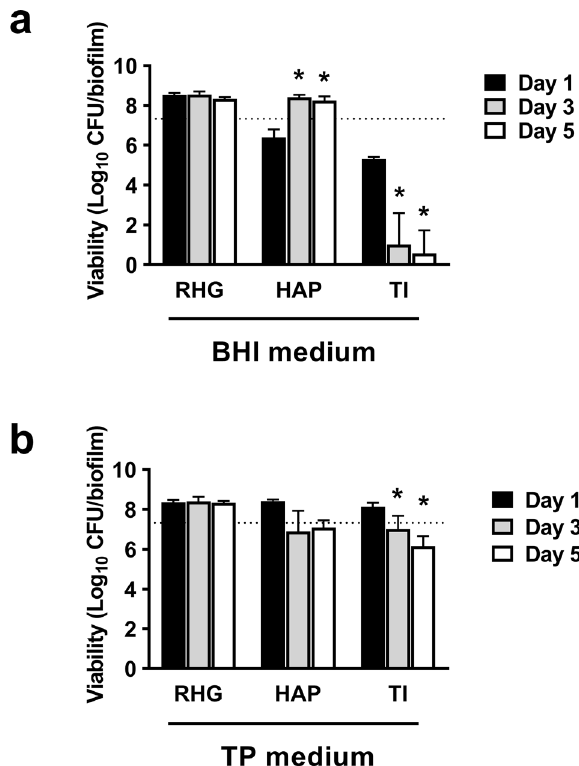
Fig. 1 Viability of microcosm bio fi lms grown on different oral substrata. The saliva inoculum was mixed with 0.7% agar containing bio fi lm growth media — either BHI ( a ) or TP ( b ), and inoculated onto one of the substrata (RHG, HAP or TI). The bio fi lms were collected for viable cell counts on day 1, 3 and 5. RHG: reconstructed human gingiva; HAP: hydroxyapatite discs; TI: titanium discs. Data represent the mean ± standard deviation of three independent experiments. * represents statistically signi fi cant difference when compared to the day 1 bio fi lms ( p < 0.05). The dotted line indicates the averaged viable cell counts of saliva inocula of all